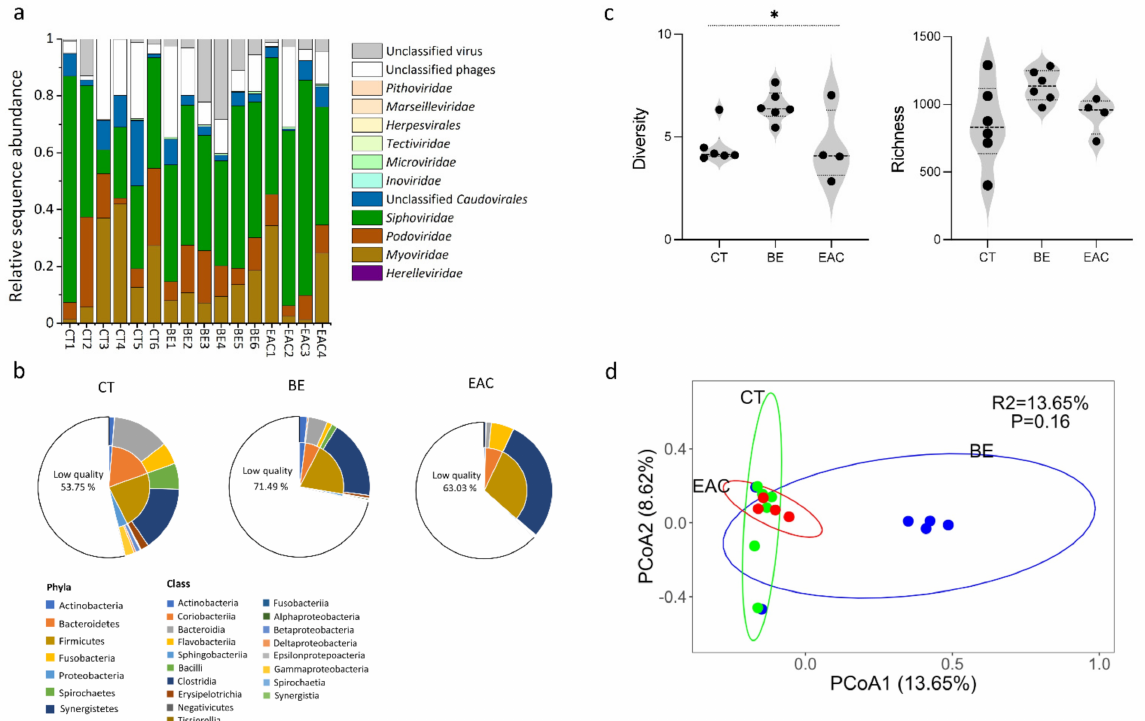
Figure 1. Composition of CT, BE, and EAC VLPs. ( a ) Relative abundance of viral families in CT, BE, and EAC; ( b ) The percentage of predicted bacterial hosts in CT, BE, and EAC. The inner cycle represents bacterial hosts at the phylum level, the outer cycle represents bacterial hosts at the class level. The low quality represents bacterial hosts predicted by contigs with a length lower than 10 kb and the score was lower than 95%; ( c ) Viral alpha diversity including richness (Ace) and diversity (Shannon) in samples from CT, BE, and EAC; ( d ) PCoA plot of the viral community composition based on the Bray–Curtis distances in CT, BE, and EAC samples. CT represents stool samples from healthy controls; BE represents stool samples from Barrett Esophagus patients; EAC represents stool samples from Esophageal Adenocarcinoma patients. Error bars indicate the average ± SE. Statistical significance was determined by Kruskal–Wallis, Dunn’s post hoc test, asterisk indicates p <